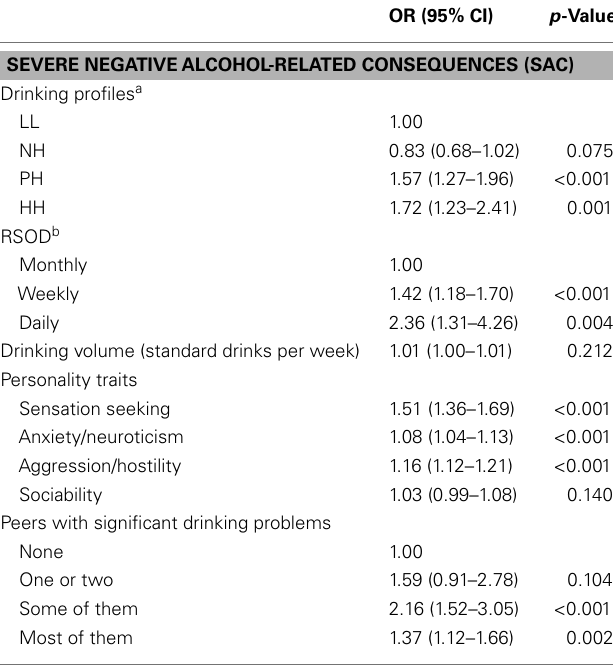
Table 5 | Logistic regression models of drinking profiles, personality traits and peers on negative alcohol-related consequences ( n = 2668)